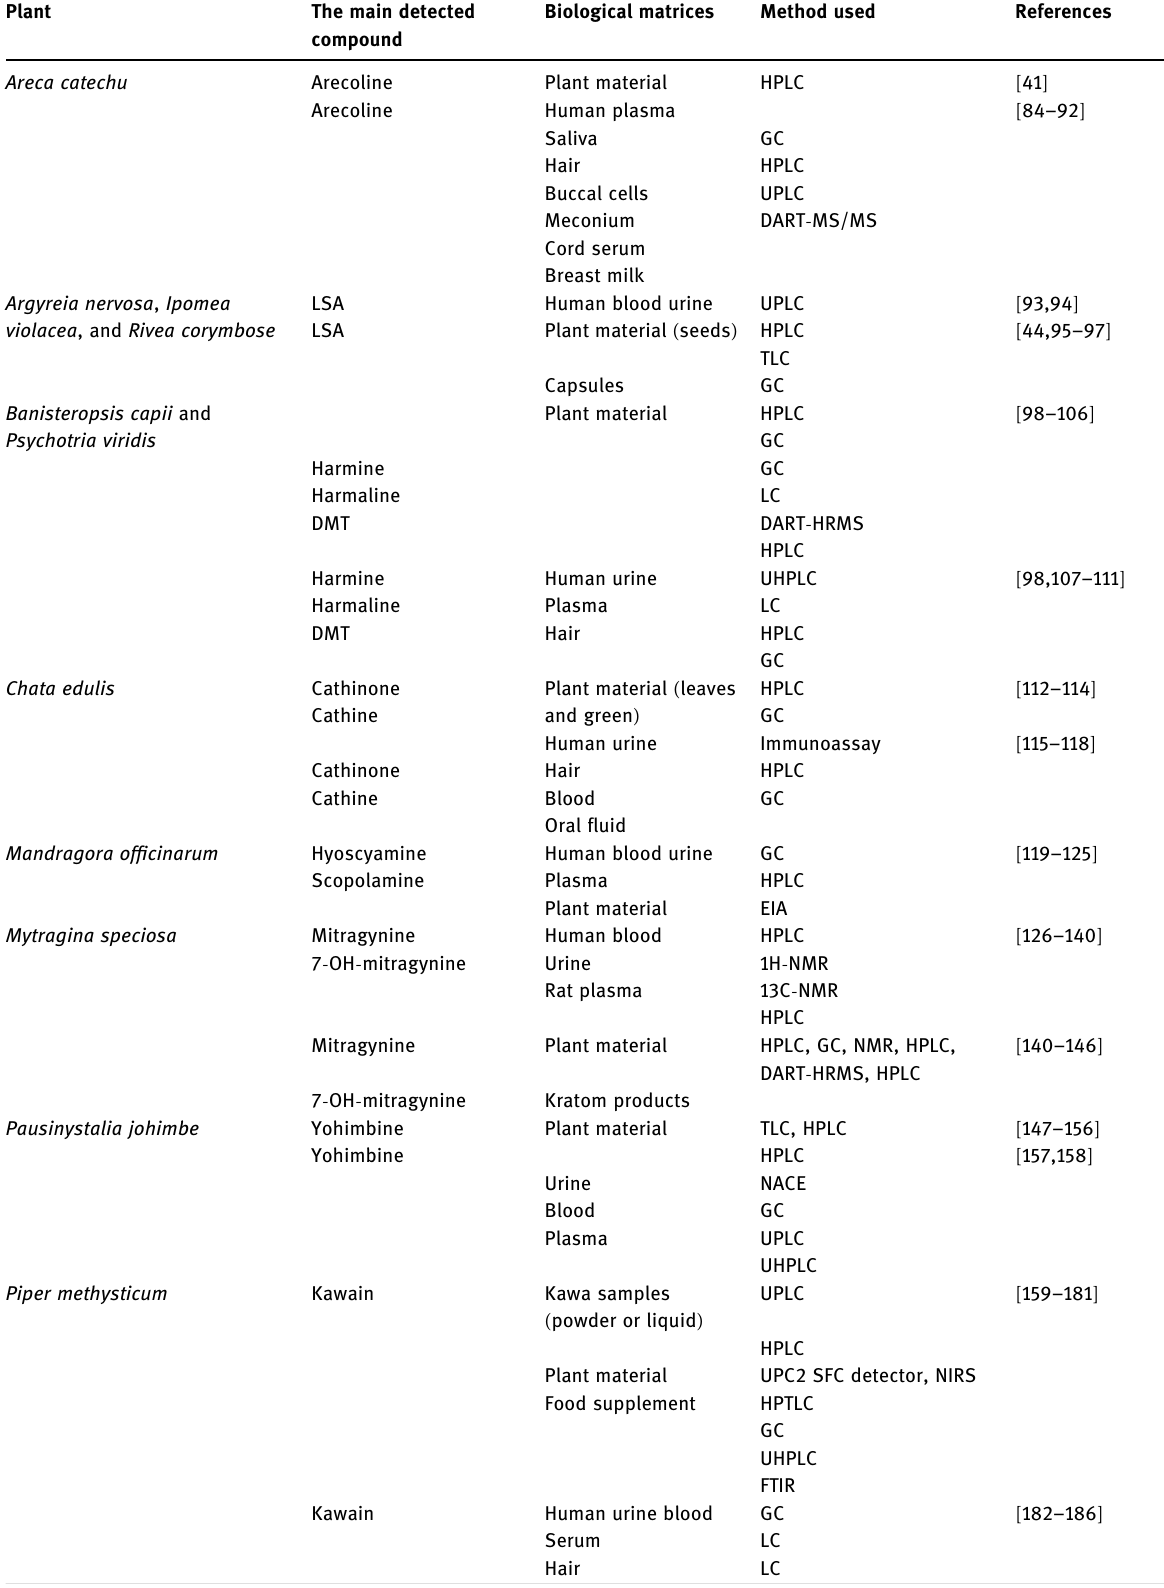
Table 1: Techniques used for the detection of new psychoactive substances of natural origin